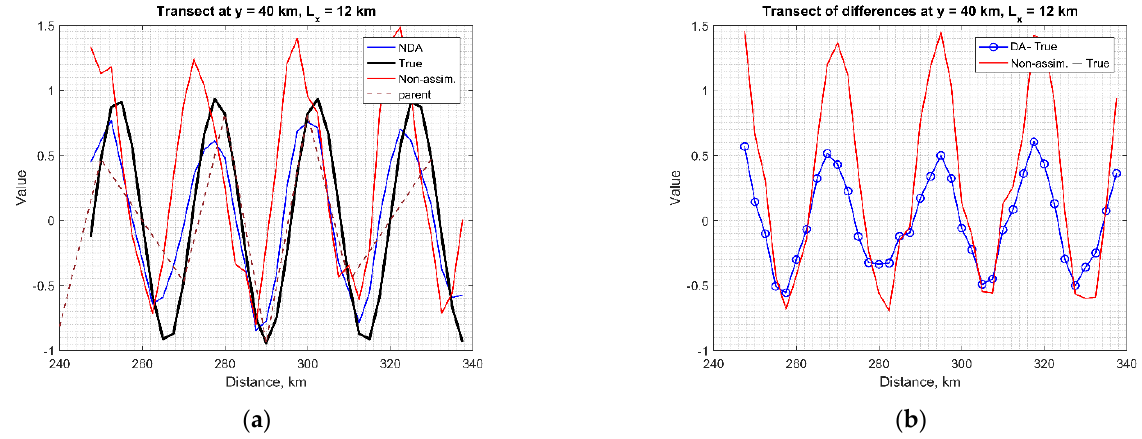
Figure 12. Transects at 𝑦 = 40 km for the multiple eddies case with 𝐿 𝑥 = 12 km. ( a ) Transects of NDA model output (blue), true solution (black), parent model (dashed dark red), and the non-assimilated child model (red); ( b ) differences between assimilated (blue) and non-assimilated (red) models and the true solution.